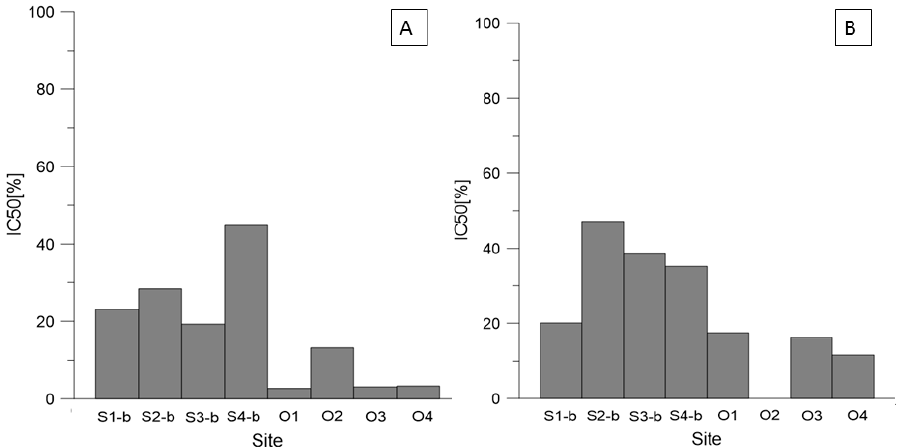
Figure 3. IC50 [%] values for soil at 100% concentration (Siechnice and Oława): ( A ) roots of A. sativa and ( B ) shoots of A. sativa